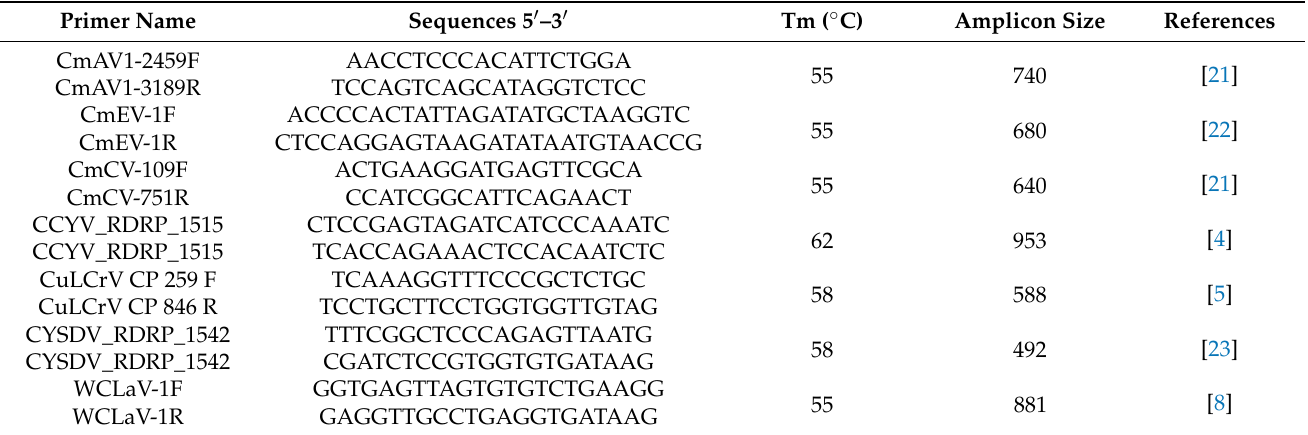
Table 1. Primers used for PCR and RT-PCR for confirmation of the